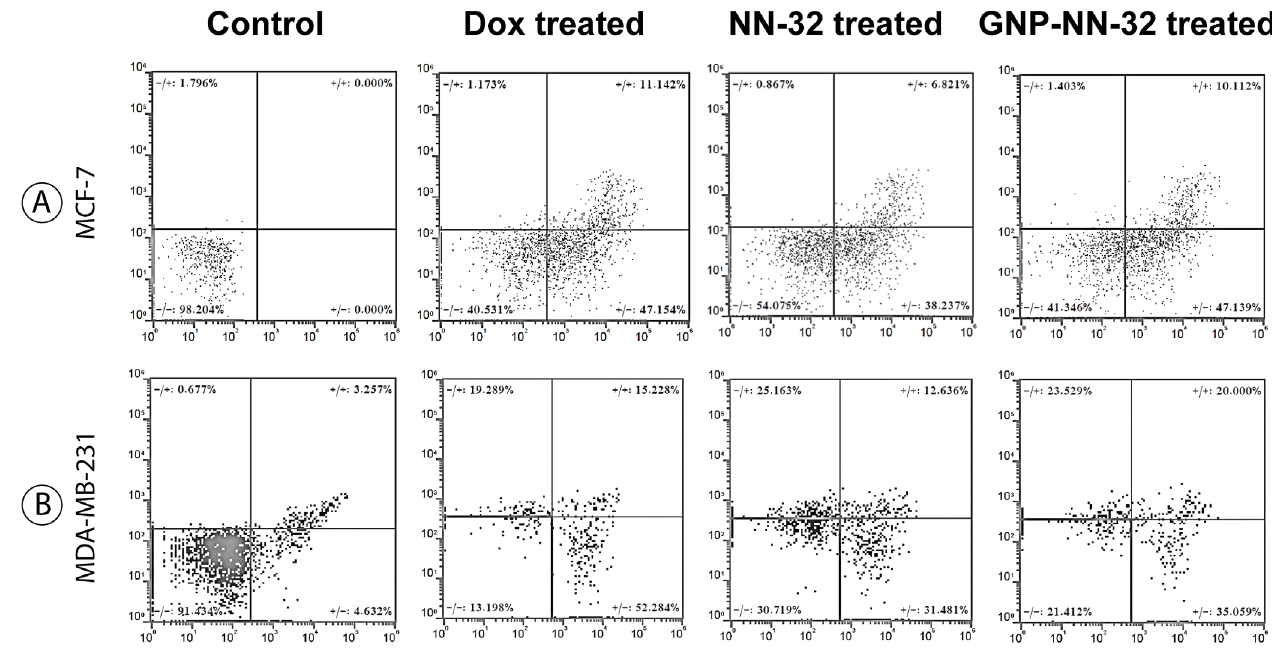
Figure 8. Flow cytometry analysis of apoptosis of human breast cancer cells stained with Annexin V-FITC PI, after treatment with doxorubicin, NN-32 and GNP-NN-32. (A) MCF-7 cells and (B) MDA-MB-231 cells.